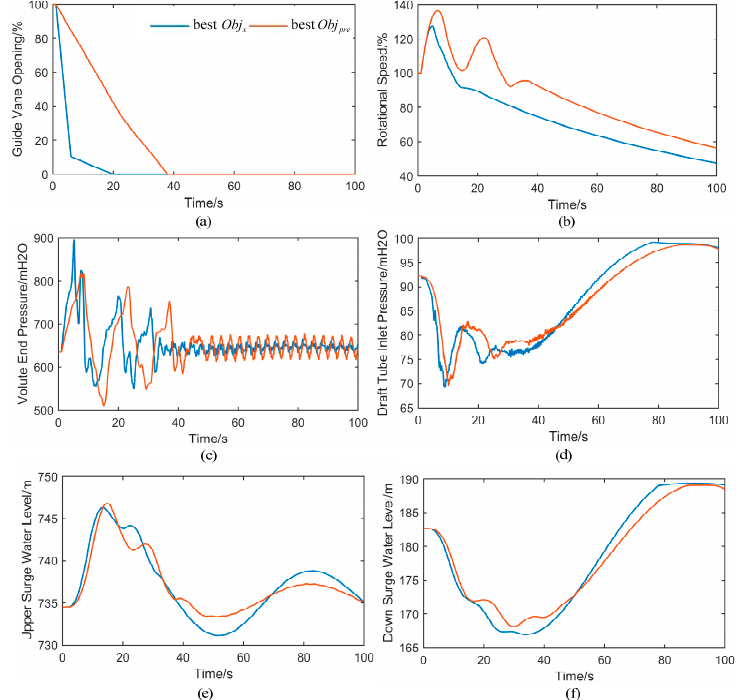
Figure 10. The transient process of minimum Obj x and Obj pre schemes of scenario 3: ( a ) guide vane closing laws; ( b ) rotational speed; ( c ) volute end pressure; ( d ) draft tube inlet pressure; ( e ) upper surge water level and ( f ) down surge water level. Table 6. The index values of the minimum Obj x and Obj pre schemes of scenario 3 (I).